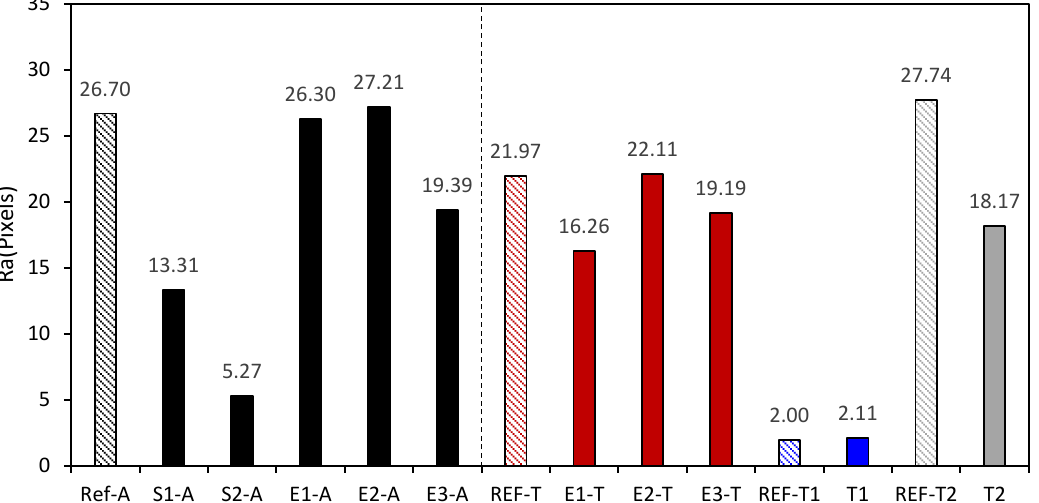
Figure 13. Surface roughness, Ra (pixels), for all the materials studied.